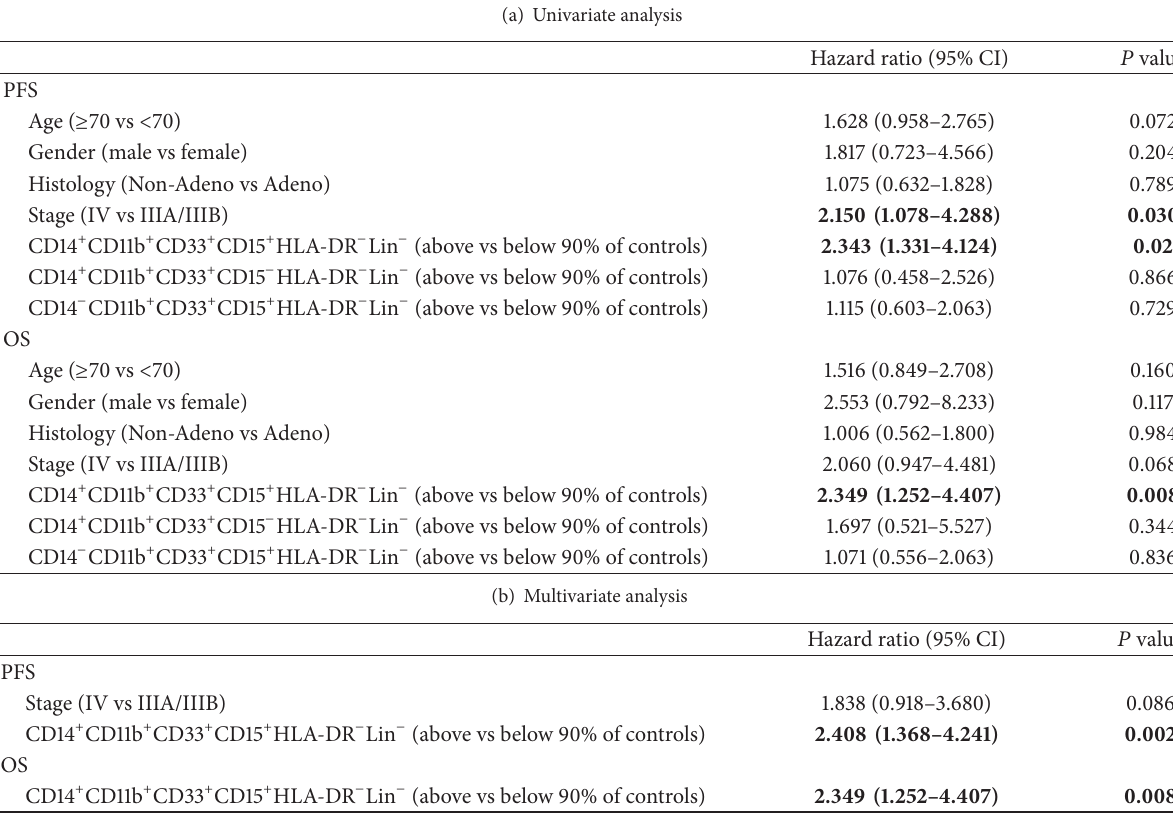
Table 4: Univariate and multivariate analysis for PFS and median OS for NSCLC patients.